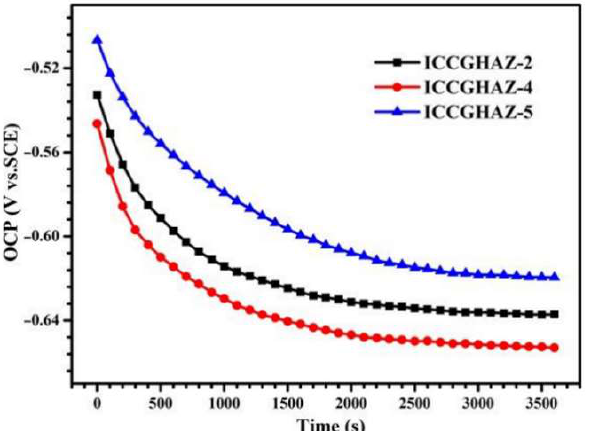
Figure 14. OCP dependent on the immersion time of the ICCGHAZs with different cooling rates in